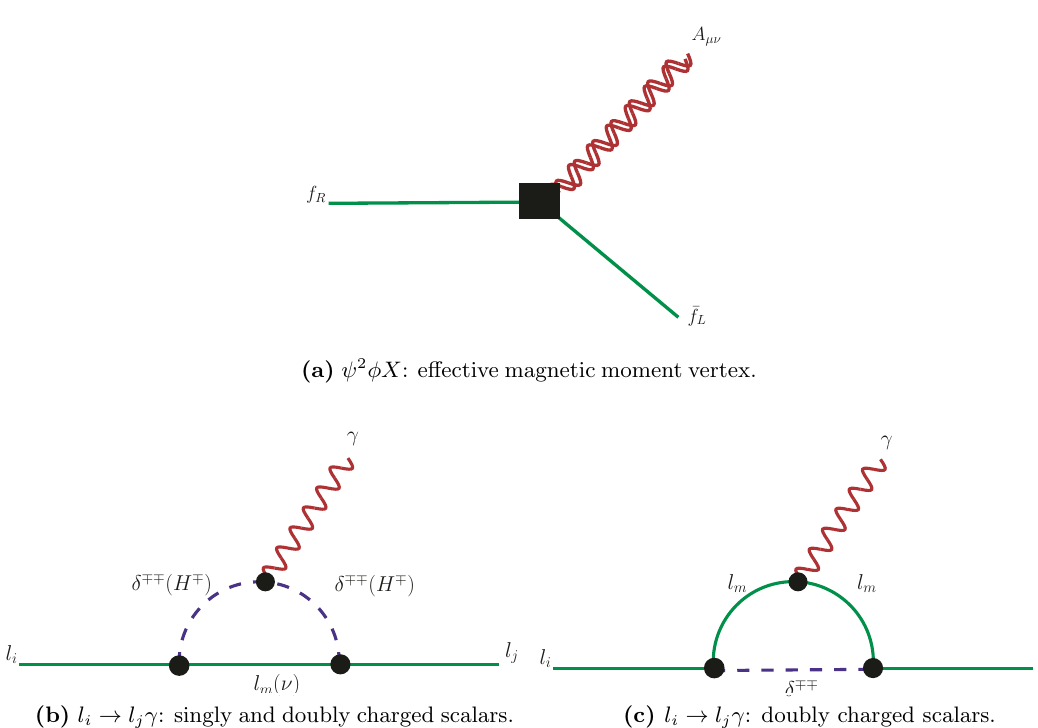
Figure 8. Feynman diagram representing the magnetic moment interactions of charged fermions: (cid:4) (a) 2 (cid:30)X class of e(cid:11)ective operators [ ] leading to magnetic moment interactions (cid:22) f L (cid:27) (cid:22)(cid:23) f R A (cid:22)(cid:23) ) with f representing charged fermions. (b) and (c) modi(cid:12)ed vertices [ ] lead to radiative decay of (cid:15) charged leptons ( l i l j (cid:13) ). For i = j = (cid:28); (cid:22); e , both diagrams contribute to the magnetic moment ! of charged leptons.